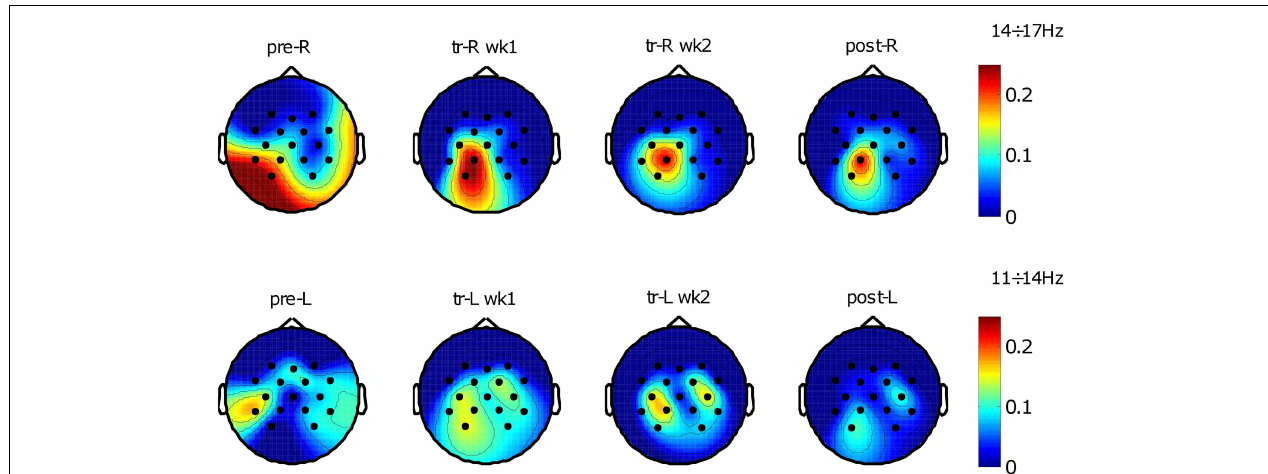
distribution related to the frequency bin 14 ÷ 17Hz identified for the right-affected arm using pre-evaluation data (number of trials N : pre-R, N = 221 ; tr-R wk1, N = 659 ; tr-R wk2, N = 501 ; post-R, N = 215 ). Bottom R 2 maps show spatial distribution related to the frequency bin 11 ÷ 14Hz identified for the left-unaffected arm using pre-evaluation data (number of trials N : pre-L, N = 216 ; tr-L wk1, N = 662 ; tr-L wk2, N = 515 ; post-L, N = 230 ).